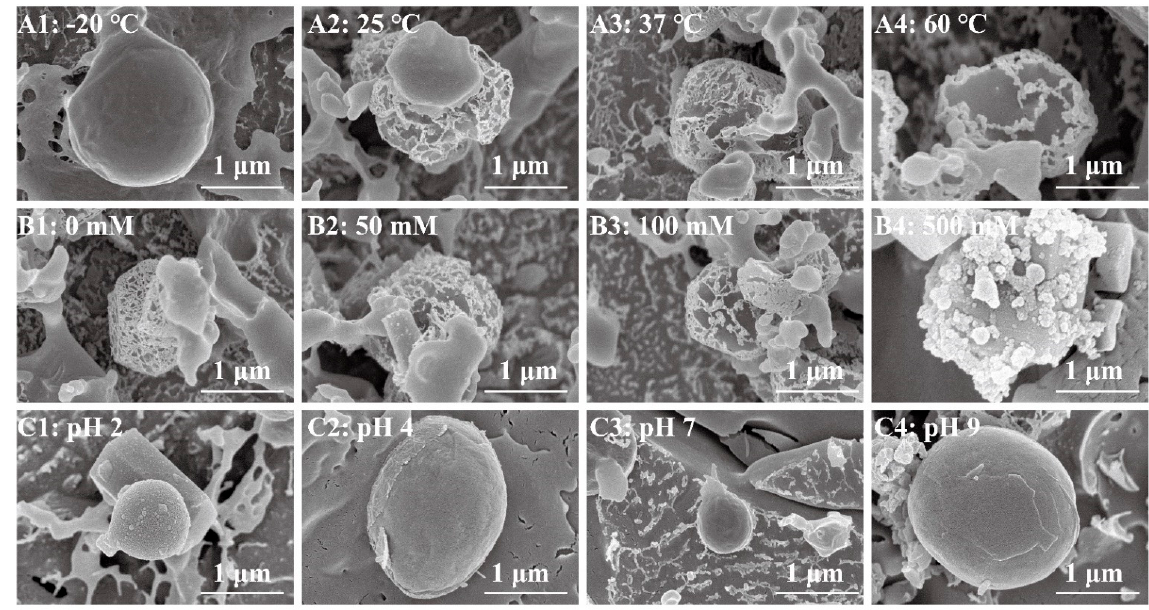
Figure 3. Cryo-scanning electron microscopy (Cryo-SEM) images of the Pickering emulsion under different environmental conditions. ( A1 – A4 ) temperature, ( B1 – B4 ) salt concentration, and ( C1 – C4 ) pH.